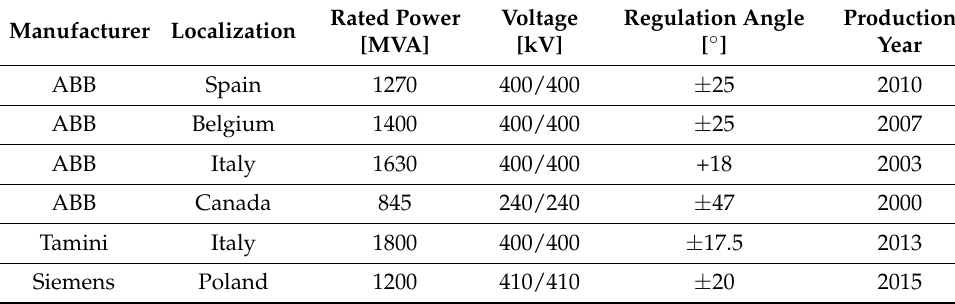
Table 1. PST units used around the world